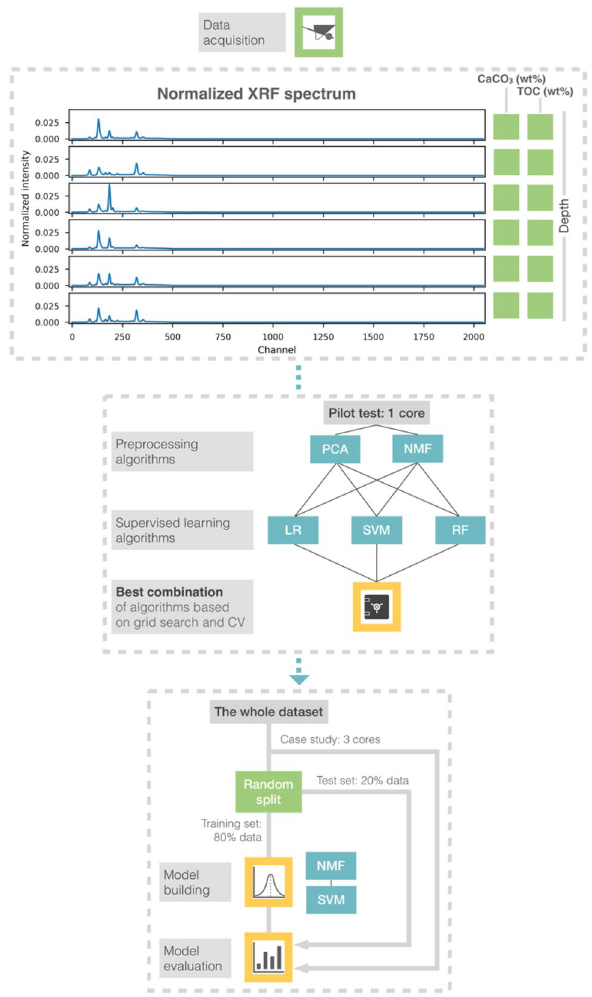
Figure 2. Workflow for the machine learning approach applied to XRF